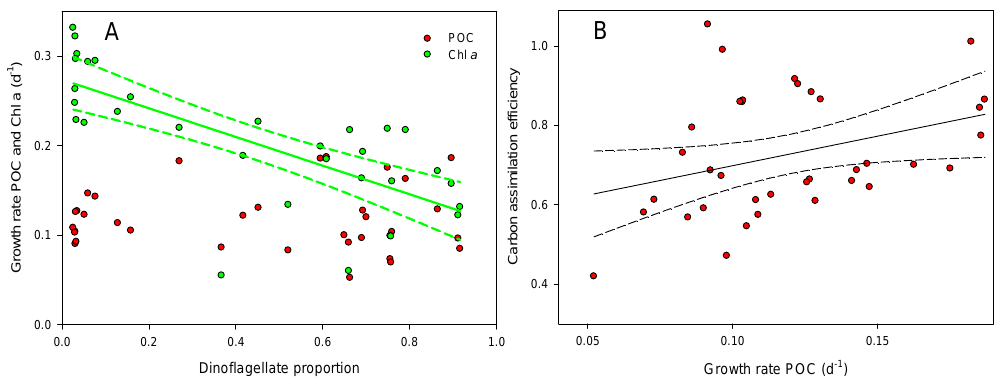
Figure 3. The growth rate during exponential growth of particulate organic carbon ( µ POC ) and Chlorophyll a ( µ Chl a ) at different dinoflag- ellate proportion of the total phytoplankton community (a) , and the relationship between carbon assimilation efficiency and µ POC (b) . No significant trend was found for µ POC , but a negative correlation was found between µ Chl a and dinoflagellate proportion. The solid line represents the linear regression (slope = − 0.16; R 2 = 0.53; p <0.0001), and the dashed lines represent the 95% confidence intervals. The carbon assimilation efficiency is the ratio between the measured growth rate in POC and the total gross production (Fig. 1). A positive correlation was found (slope = 1.49; R 2 = 0.12; p = 0.04).